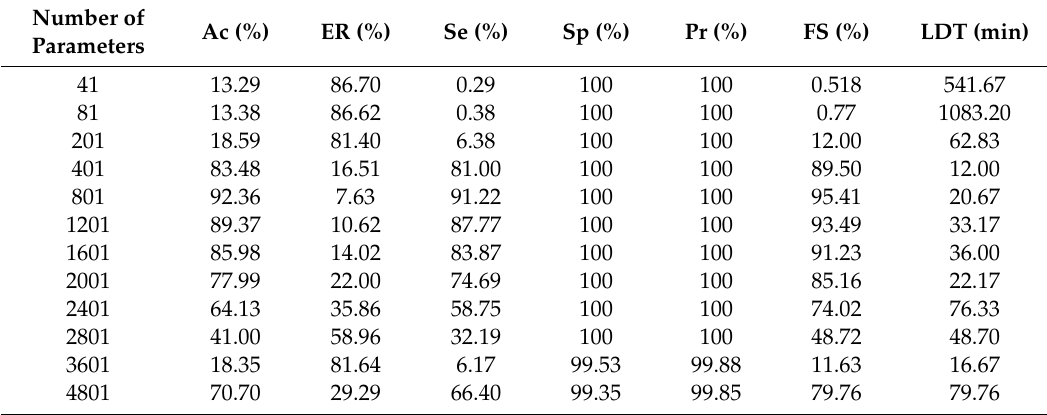
Table 4. Leak detection system performance measures with several parameters at 10 km, leak size was 5% of the nominal flow and, noise ratio was 0.2%.